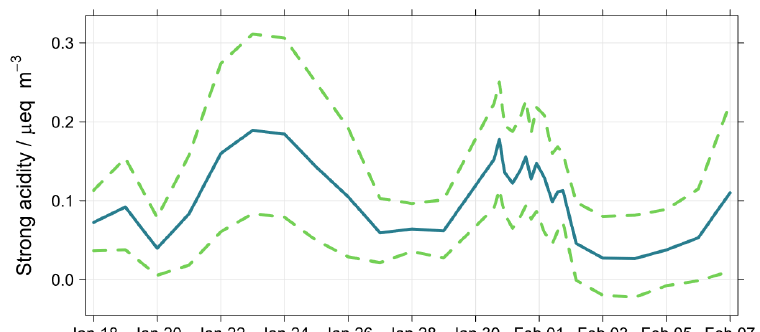
Figure 8. Predictions of particle strong acidity for the aerosol collected during the Bachok measurement campaign. Dashed lines represent predictions of minimum and maximum limits of strong acidity.